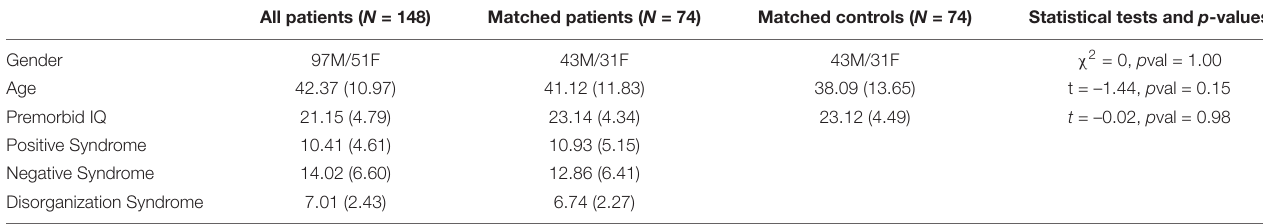
TABLE 1 | Summary of demographic and clinical